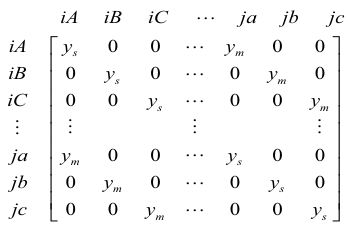
6 6 admittance matrix can be given by ×